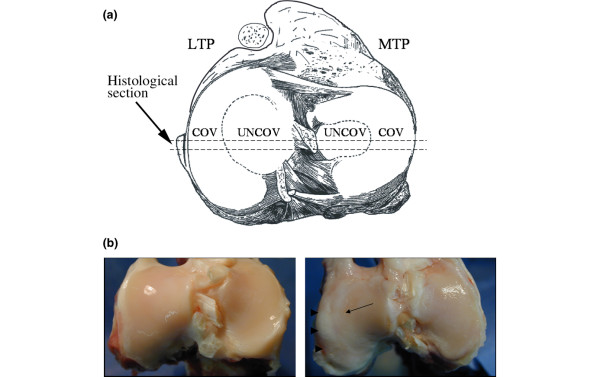
Sheep meniscectomy model of early osteoarthritis (a) Schematic representation of left ovine tibial plateau demonstrating medial (MTP) and lateral (LTP) plateaux, further separated into regions normally covered (COV) and uncovered (UNCOV) by menisci. Full-thickness coronal sections were taken for histological evaluation as indicated by the broken line. (b) Photographs demonstrating typical osteoarthritic changes observed after lateral meniscectomy (MEN), including surface fibrillation (arrow) and osteophyte formation (arrowheads).